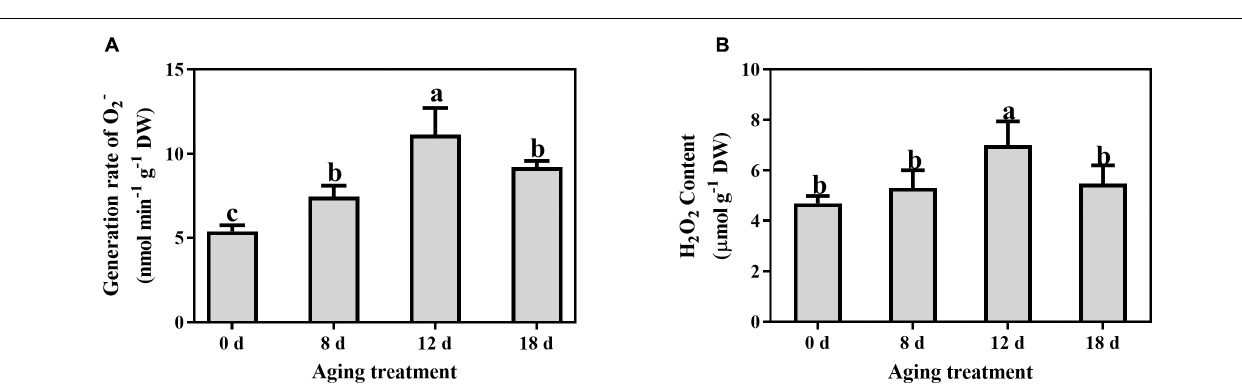
FIGURE 3 | Effects of artificial aging treatment on (A) generation rate of O 2 - and (B) content of H 2 O 2 . Data shows the mean ± SD of three biologically independent experiments. Columns marked with different letters (a-c) are statistically significantly different ( p < 0.05).